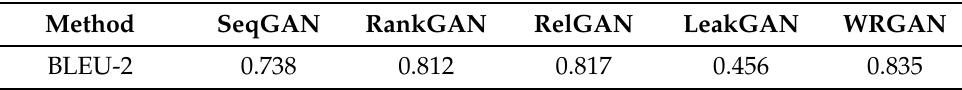
Table 4. The BLEU-2 scores on the Chinese poetry dataset with Dimension = 128. For BLEU scores, the higher the